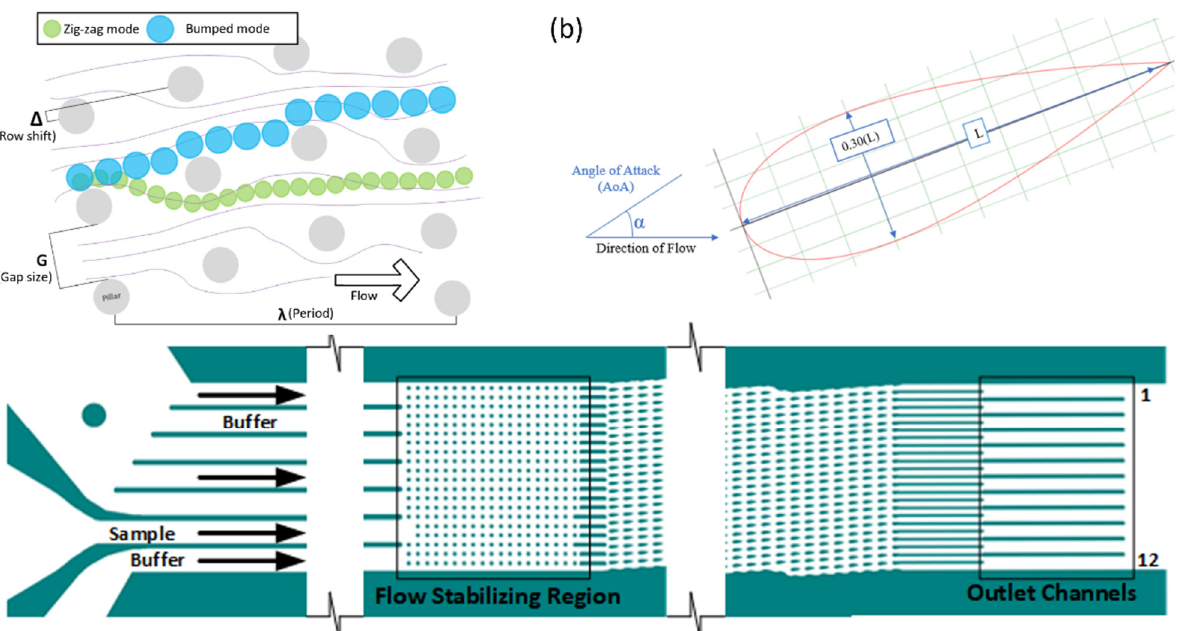
Figure 1. ( a ) The DLD modes “zig-zag” (green) and “bumped” (blue) occur depending upon the size of the particle relative to the critical diameter of the device, which is calculated based the parameters of the device, such as gap size (G), row shift ( Δ ), and period ( λ ). ( b ) NACA 0030 Airfoil with a negative angle of attack. ( c ) The DLD device used consisted of 3 inputs: one sample input and two buffer inputs. There was a flow stabilizing region of cylindrical pillars and the displacement or pillar region of airfoil-shaped pillars. There were 12 outlet channels that were the focus of the observation.